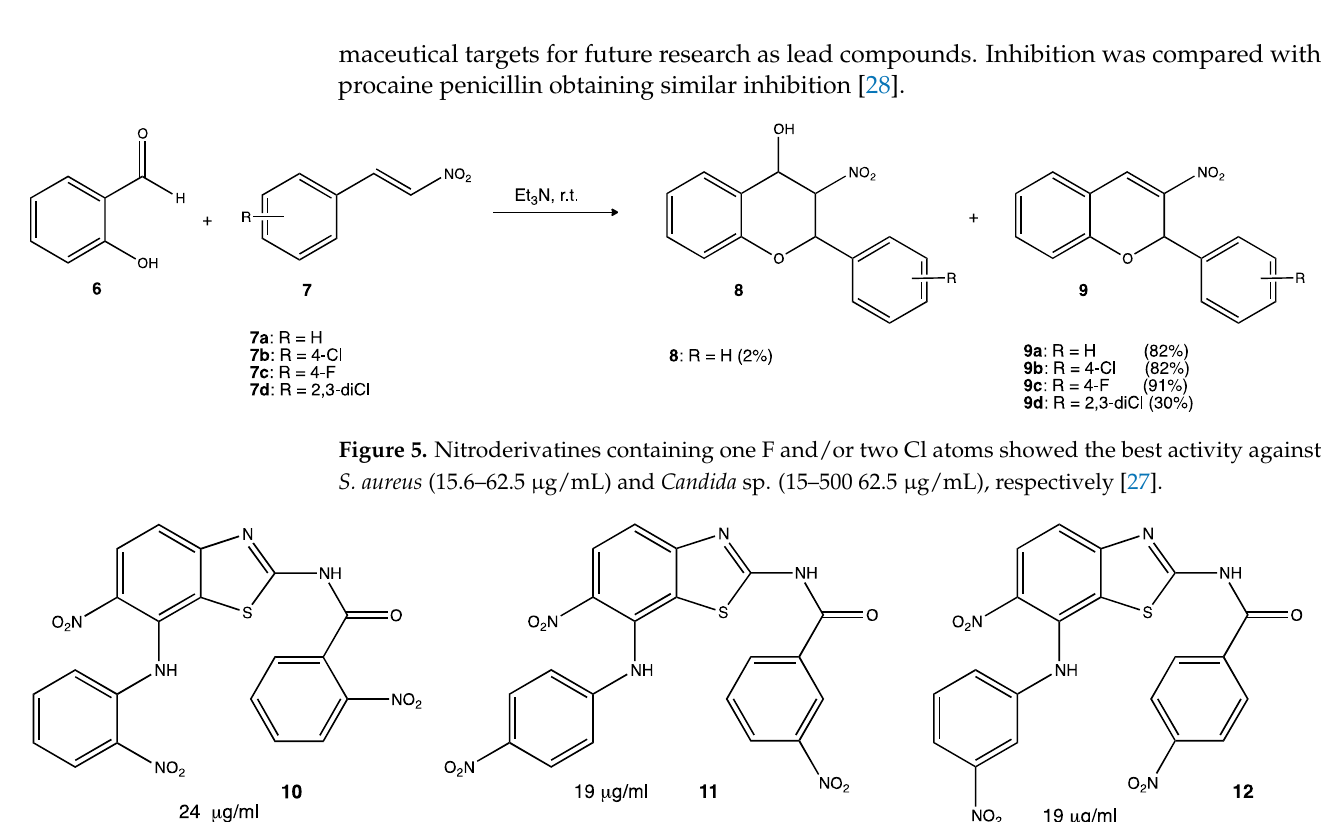
4 of 14 Figure 3. Nitrated pyrrolomycins with potential antibacterial activity [24]. For many years, the coordination chemistry of transition metals was not considered an important part of medicinal chemistry. However, in recent years, metal complexes with Schiff bases as ligands have gained attention due to their wide potential biological activity. A series of 4-nitro-1,2-phenylendiamine metal complexes were synthesized and tested against Gram-positive microorganisms ( Streptococcus mutans and Staphylococcus aureus ) Gram-negative ( Escherichia coli, Klebsiella pneumonia and Pseudomonas aeruginosa ) and the fungus Candida albicans . A total of nine new compounds were obtained but only the Zn(II) complex 5 showed significant activity against Streptococcus mutans (Figure 4). Antibacte- rial activity was reported as the inhibition zone diameter, with 40.7 mm being the inhibi- tion obtained with the Zn(II) complex. The rest of the compounds with other metals such as Co(II), Cr(III), Fe(III) and Ni(II) showed little or no activity at all [26]. Even when these results might seem discouraging, these kinds of compounds represent new synthetic methods to be addressed in future research or metal complexes with biological activity. Figure 4. Structure of the Zn(II) complex against Streptococcus mutans [26]. There is an increasing interest in developing new antimicrobial agents not only be- cause of the growing resistance to antibiotics but also because of the risk of nosocomial infections (infectious diseases acquired within a hospital). In some regions, these types of infections could reach up to 40% of hospitalized patients. Gram-positive bacteria are re-